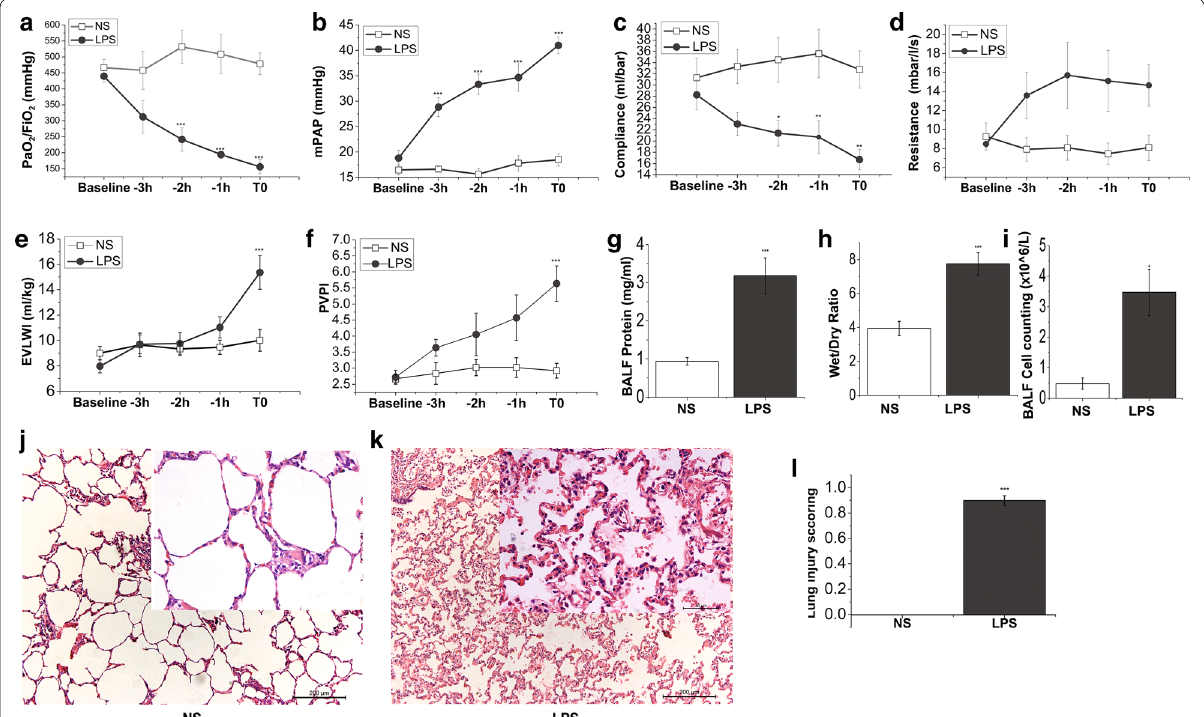
Fig. 1 LPS impairs lung function and alveolar-capillary barriers. Pigs were allocated into intravenous saline and LPS group, respectively. Parameters of oxygenation, hemodynamics and lung mechanics were recorded at different time points from baseline to the end of the experiment (T0). BALF and lung tissues were collected at T0. PaO 2 /FiO 2 ( a ) was measured by using blood samples from femoral artery on a blood gas analysis instrument. The value of mPAP ( b ) was gained by Swan-Ganz catheter implantation into jugular vein. Compliance ( c ) and resistance ( d ) were recorded by using Drager Evita 4 ventilator. EVLWI ( e ) and PVPI ( f ) were measured by PiCCO system at baseline and a series of time points until ALI was well established (T0). g Whole protein content in the BALF of pigs was detected by using BCA protein assay kit. h The ratio of wet/dry lung weight of saline control and LPS challenge pigs. i Whole-cell counts in the BALF collected from both groups of pigs. j and k were the representative histology sections of controls and LPS challenge pigs. HE sections are from one representative animal per group. l Lung injury scores were calculated according to ATS report which was in detail described in the “Methods.” Data points are expressed as mean SEM, N 6 of each group. Statistical significance ± = between saline and LPS group per point of measurement is shown as * P < 0.05; ** P < 0.01; *** P < 0.001,